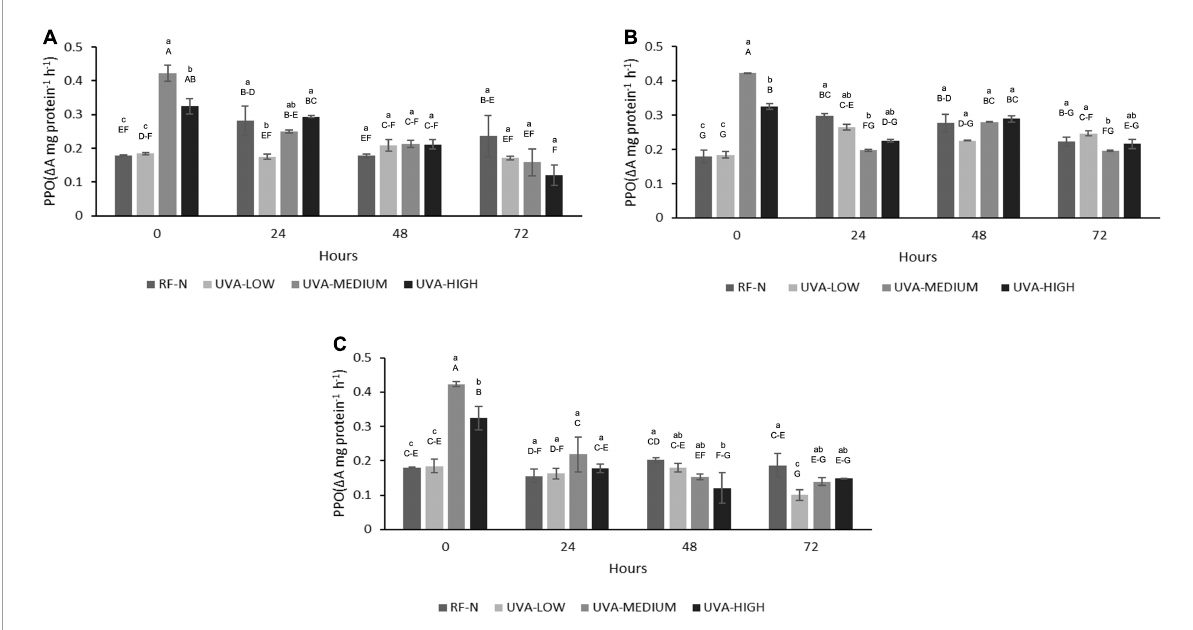
FIGURE2 Polyphenol Oxidase (PPO) activity of UVA-treated strawberry by-products during storage at (A) 5 ◦ C, (B) 10 ◦ C, (C) 15 ◦ C. RF-N: Strawberry agro-industrial by-product control. UVA-LOW: RF irradiated with 28.8 KJ/m 2 . UVA-MEDIUM: RF irradiated with 57.6 KJ/m 2 . UVA-HIGH: RF